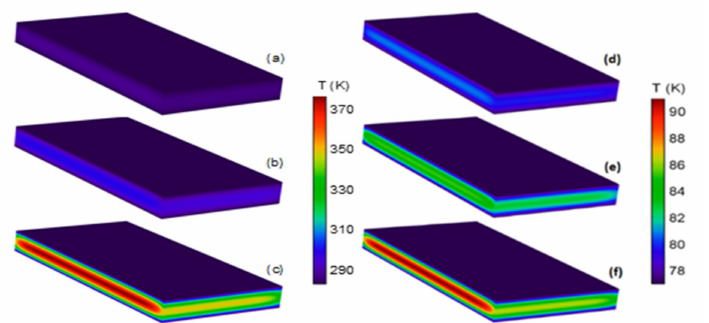
Figure 14. Temperature distribution of the top–bottom-pumped Ti:Sa slab for 300 W ( a ), 1 kW ( b ), and 5 kW ( c ) pump powers and 283 K cooling temperature, and for 10 kW ( d ), 20 kW ( e ), and 30 kW ( f ) powers and 77 K cooling temperature. For better visibility, only half of the slab is visualized. The pump wavelength is 450 nm, and crystal size of 10 × 10 × 1